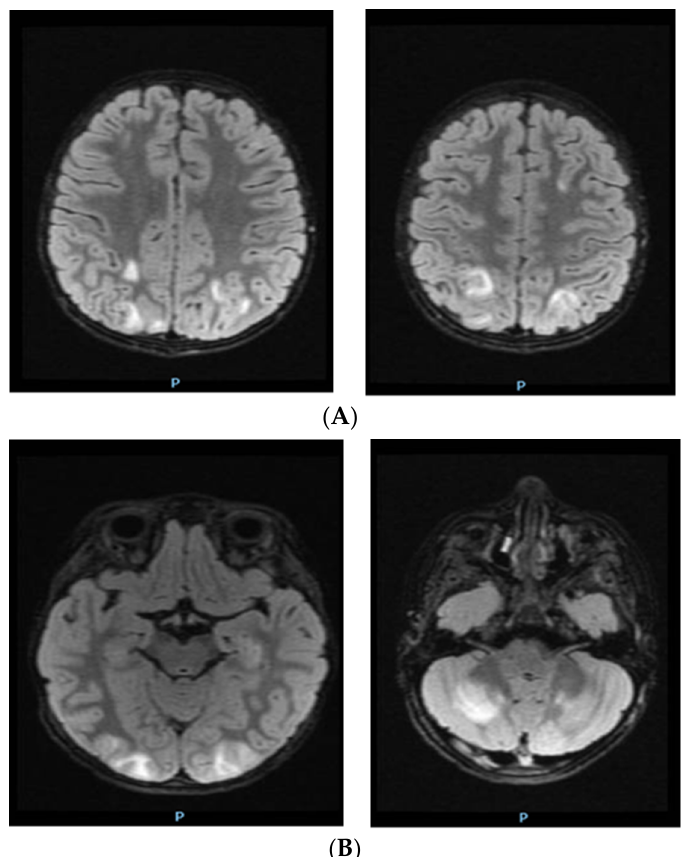
in the bilateral frontal and left cerebellar regions.